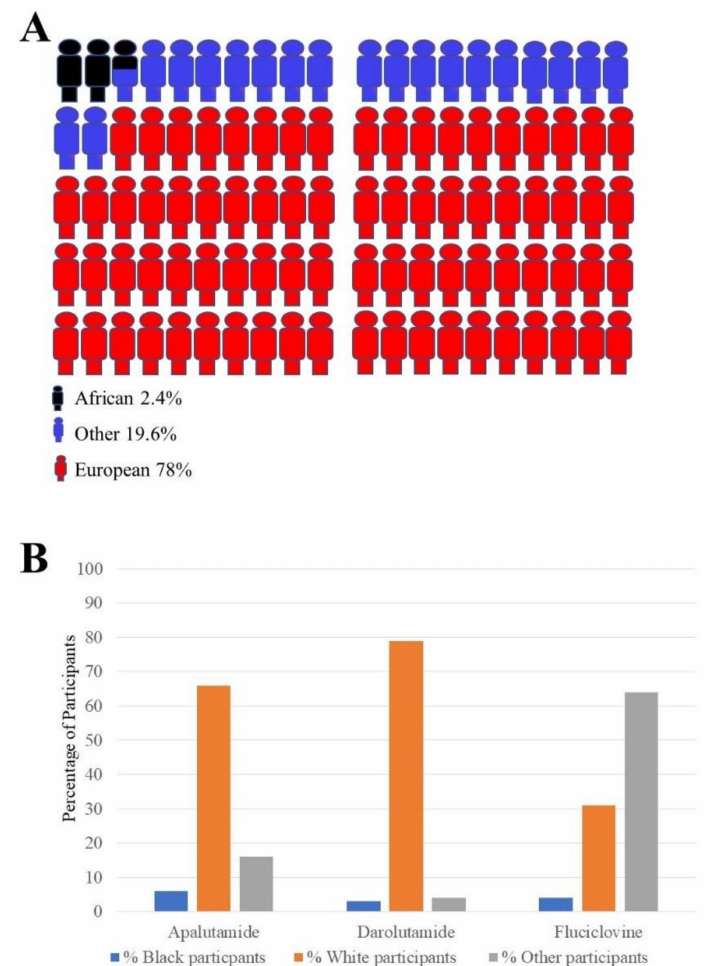
Figure 3. Racial disparitis in genome wide association studies (GWAS) and clinical trials enrolment: ( A ) Different populations’ contributions to new genomic related discoveries. Compared to other populations such the European group or other population groups, there is little participation of the African population in genomic related studies. These numbers come from participants taking part in a large number of studies ( n = 110291); ( B ) summary of enrolment of black and white men in representative clinical trials for three Food and Drug Administration (FDA)-approved PCa drugs. The number of white participants enrolled for all three PCa FDA approved drugs (2016–2019) appears to be higher than the number of black participants in all three studies. (Apalutamide study n = 1207) (Darolutamide study n = 1509) (Fluciclovine study n =